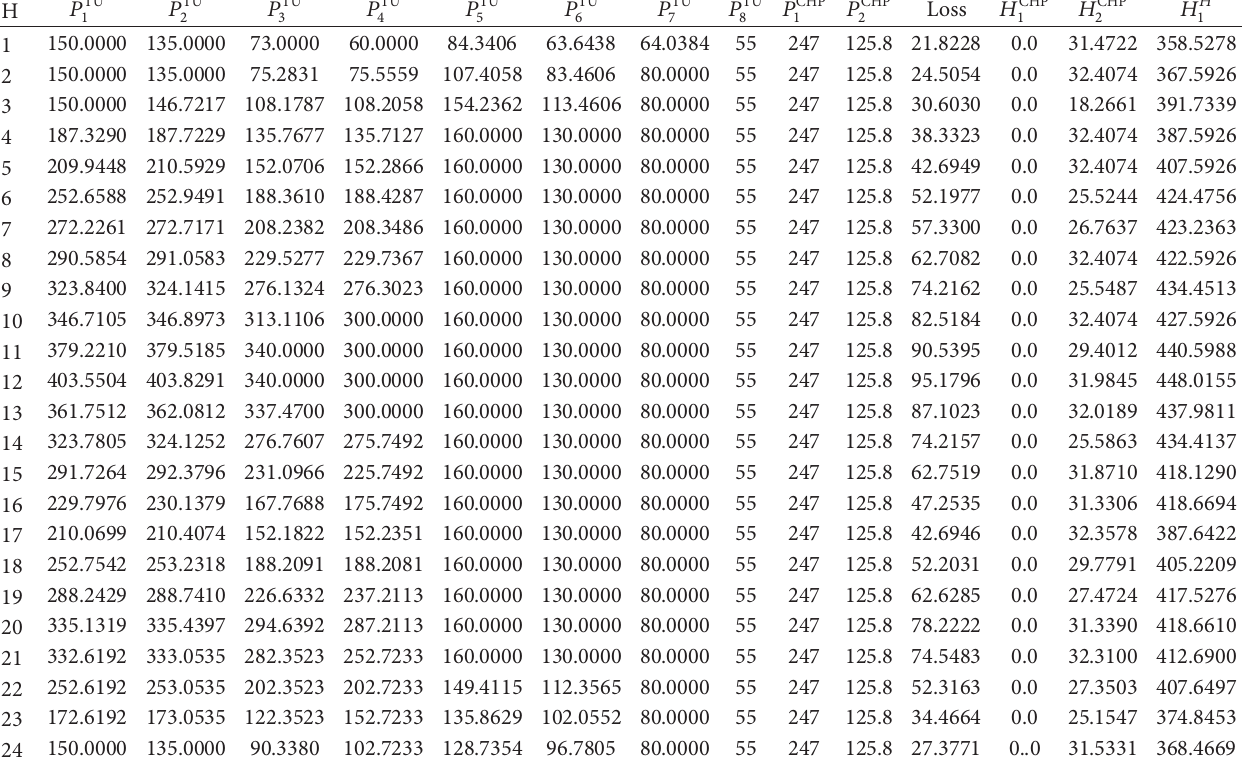
Table 7: Hourly heat and power schedule obtained from